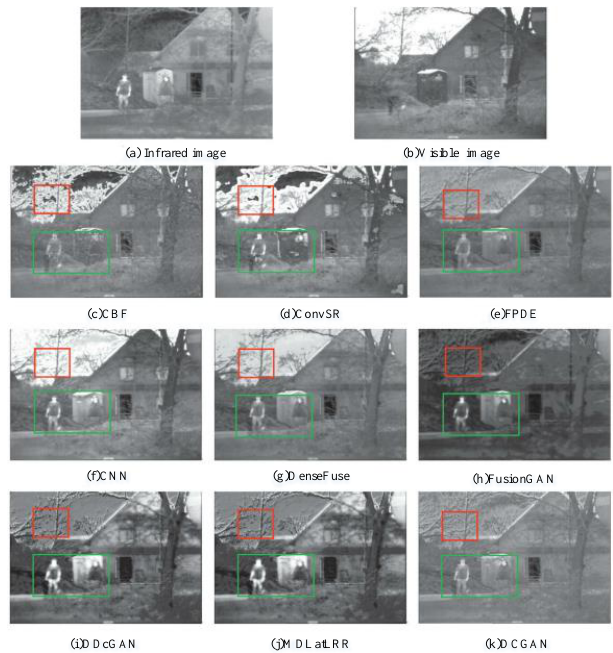
Figure 5. Comparison of fusion results of ‘Two men in front of